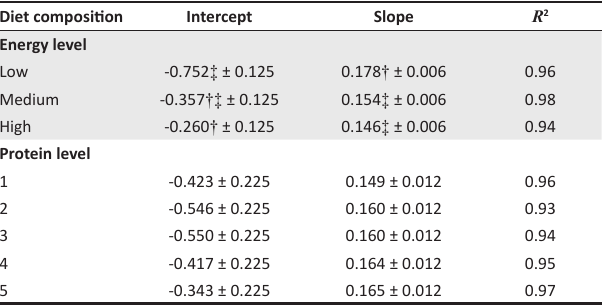
TABLE 4: Linear regression coefficients (±S.E.) for the increase in empty body protein weight (kg) with age of ostrich chicks (days) analysed for increasing dietary energy and protein levels.